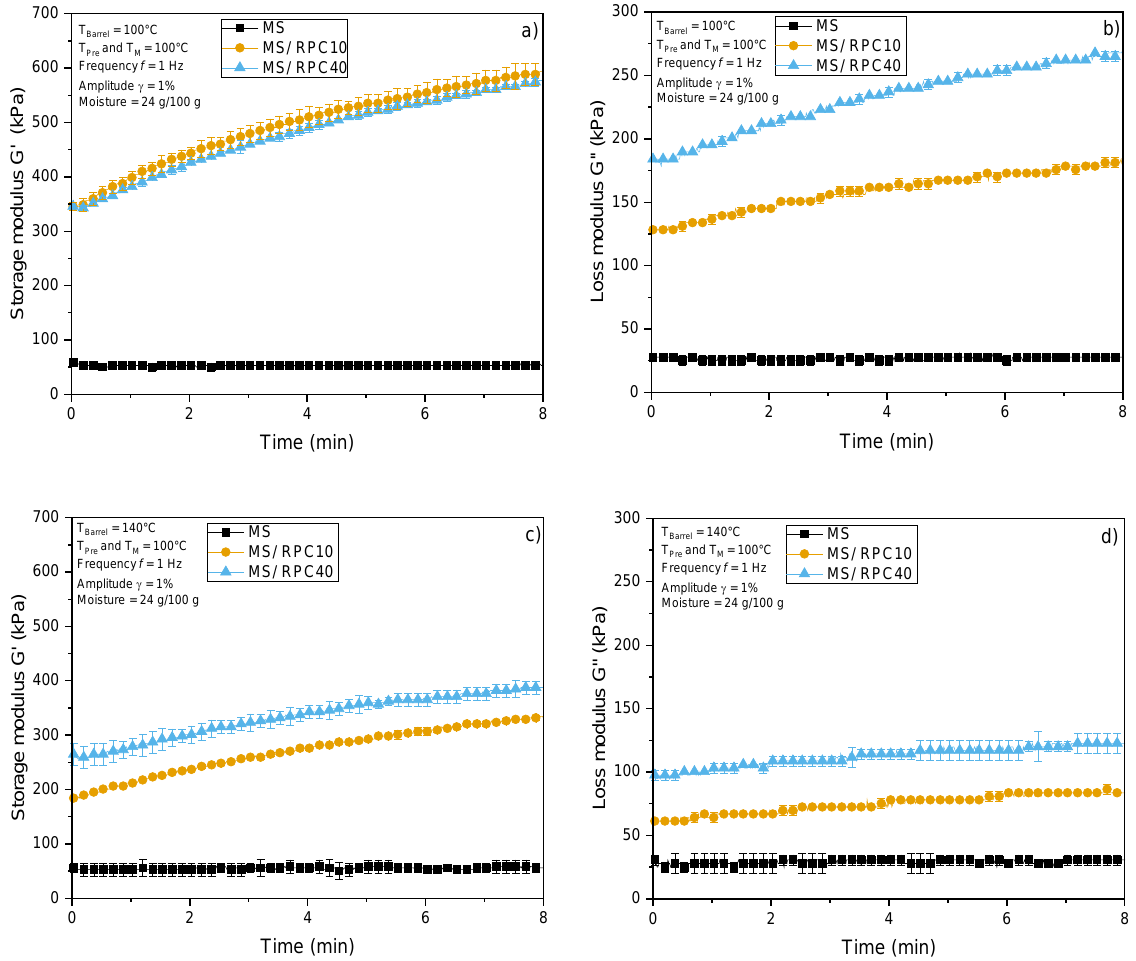
Figure 5. Storage modulus G’ ( a , c ) and loss modulus G” ( b , d ) (kPa) as a function of treatment time (min), pre-treatment and measurement temperature (T Pre , T M ) of maize starch (MS) and maize starch blended with 10 or 40 g/100 g (w.b.) rapeseed press cake (RPC) rehydrated to a moisture content of 24 g/100 g (d.m.). The samples were extruded at a moisture content of 24 g/100 g (d.m.) and barrel temperatures (T Barrel ) of 100 or 140 °C.